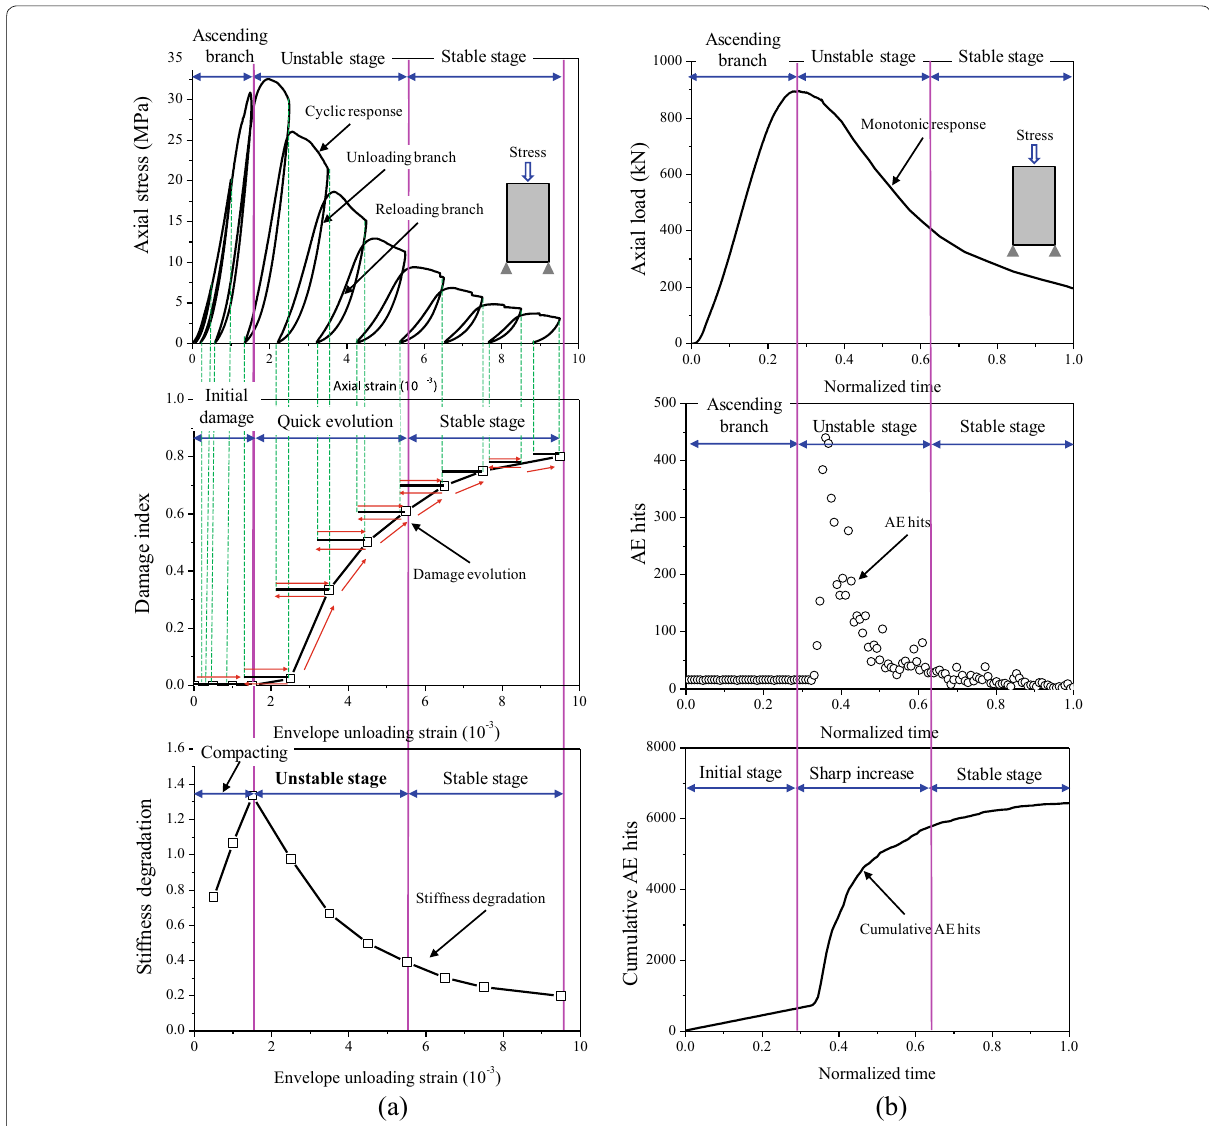
Fig. 10 Typical cyclic stress–strain curve and the corresponding damage evolution of concrete. a Based on cyclic parameters. b Based on AE results under monotonic